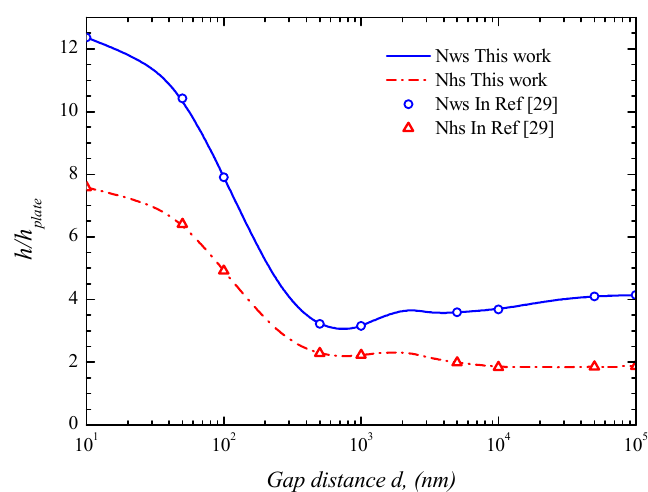
Figure 4. Comparison of the heat transfer coefficient in this work with that in Liu et al. [29].